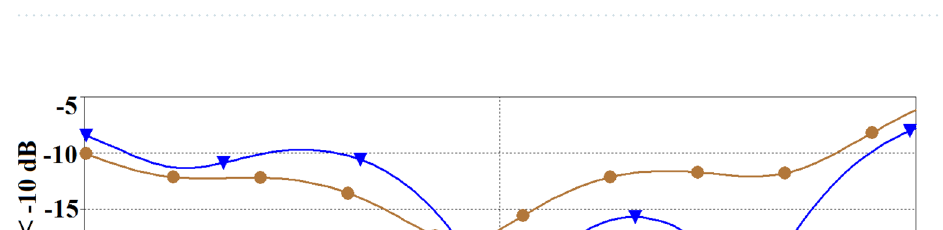
Table 1. Structural parameters of the antenna (in microns & guide-wavelength).